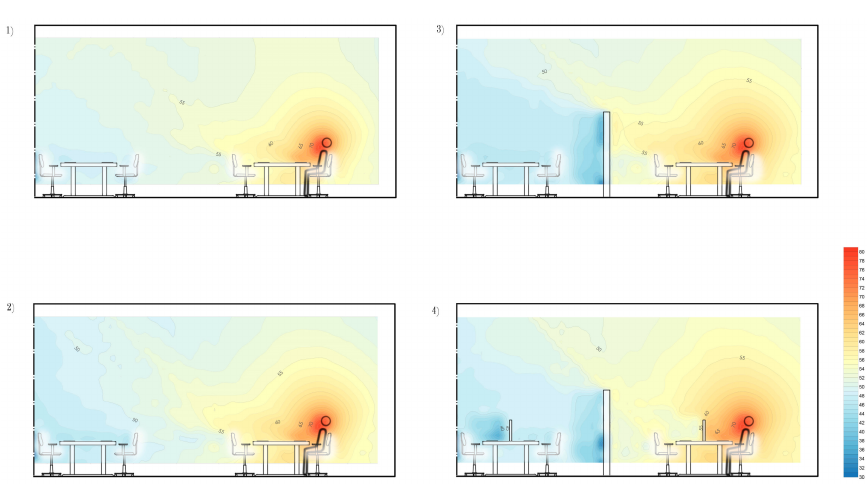
Figure 9. Example of sound source and receivers used to obtain D 2,S(box) in ‘C’ office type.